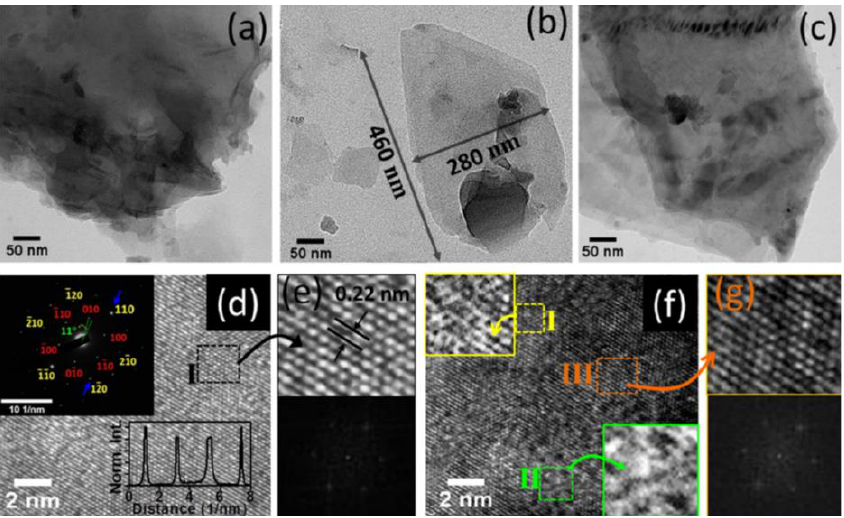
Figure 22. The effect of irradiation time on the formation of GNS: ( a ) t = 20 min, ( b ) 30 min, ( c ) 50 min, ( d ) HRTEM for t = 30 min sample and its FFT ( e ), ( f ) HRTEM for t = 50 min sample and its FFT ( g ). Reprinted with permission from Ref. [88]. 2020, Elsevier.